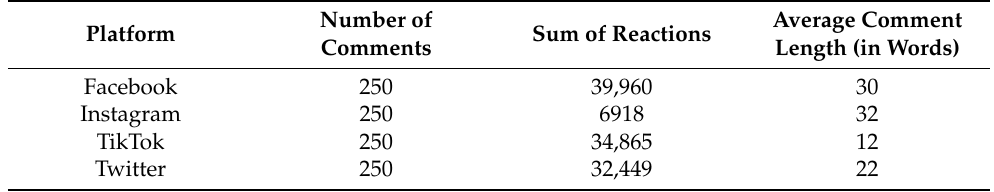
Table 1. Number of reactions and the average length of the comments included in the study.